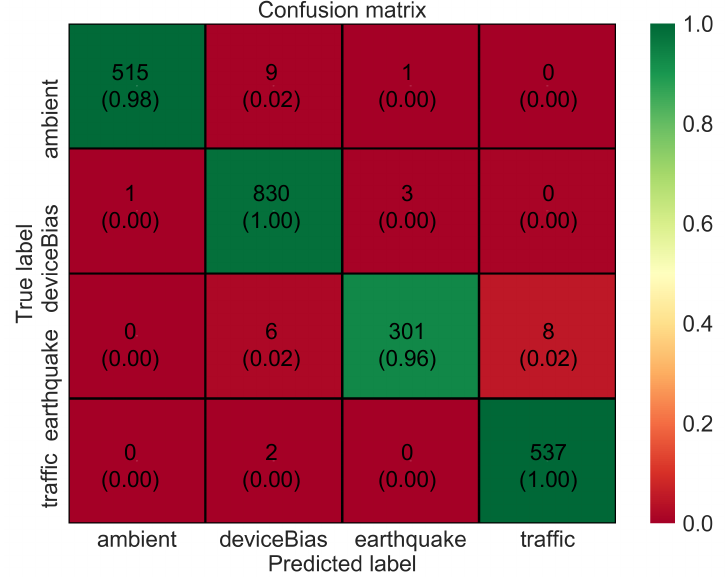
Figure 9. CNN model accuracy and loss for augmented dataset.